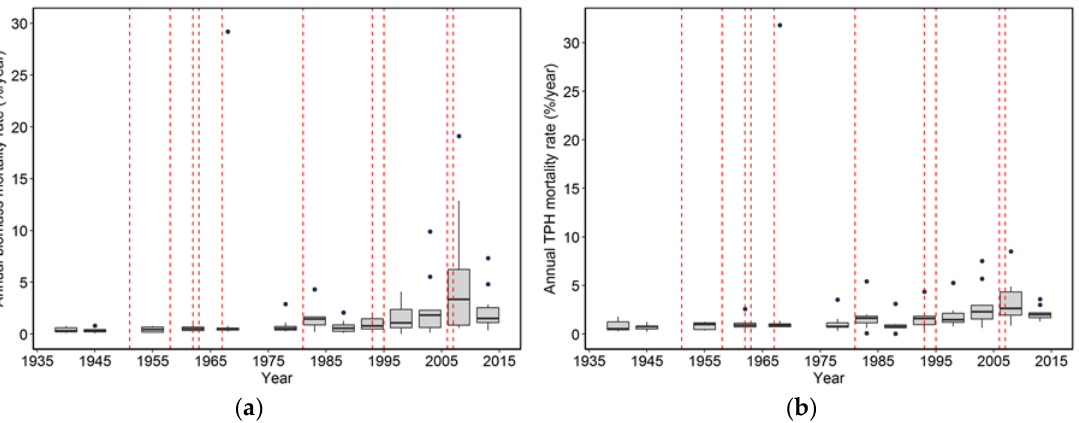
Figure 3. Median and range of the annual rate of tree mortality (%/year) across ten permanent plots based on bole biomass ( a ), and number of trees per ha ( b ). Mortality values for 1962 are interpolated for all stands except CH06 which was reconstructed. The red vertical lines indicate major wind events.